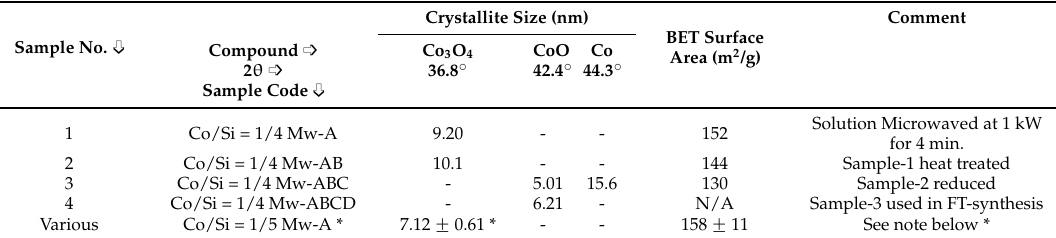
Table 2. Summary of XRD and BET surface area characteristics of Co/Si catalysts at various stages processing. of